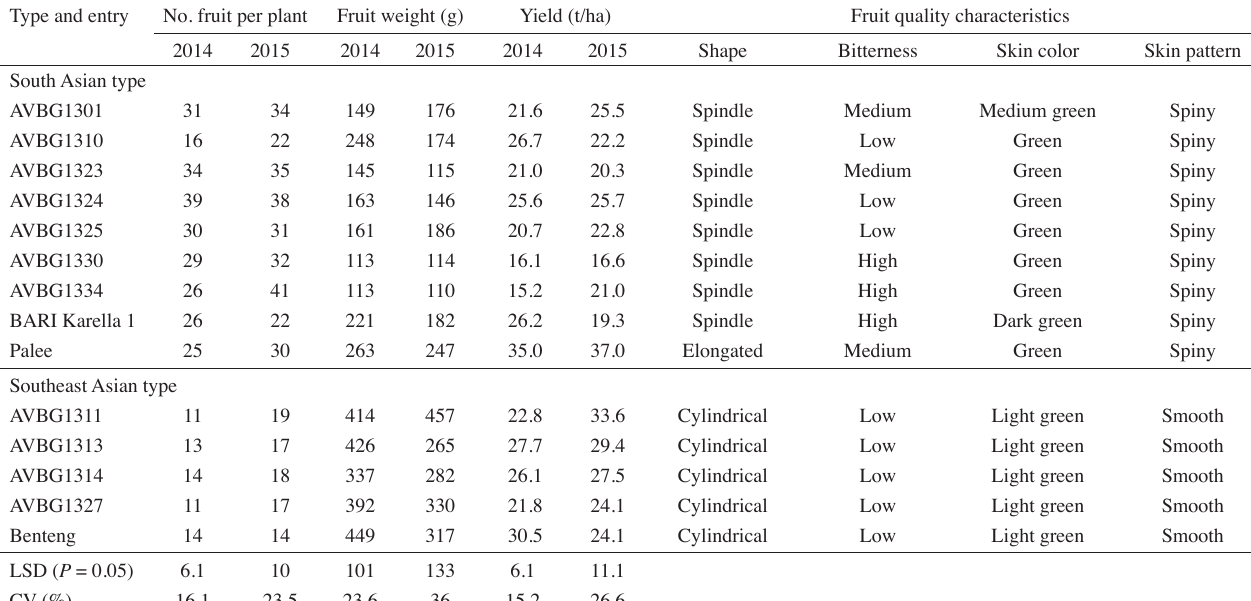
Tab. 1: Means of three yield parameters, and four fruit quality characteristics of 11 South Asian and Southeast Asian type bitter gourd breeding lines and three cultivars, field evaluations in 2014 and 2015 at Kamphaeng Saen, Thailand. Type and